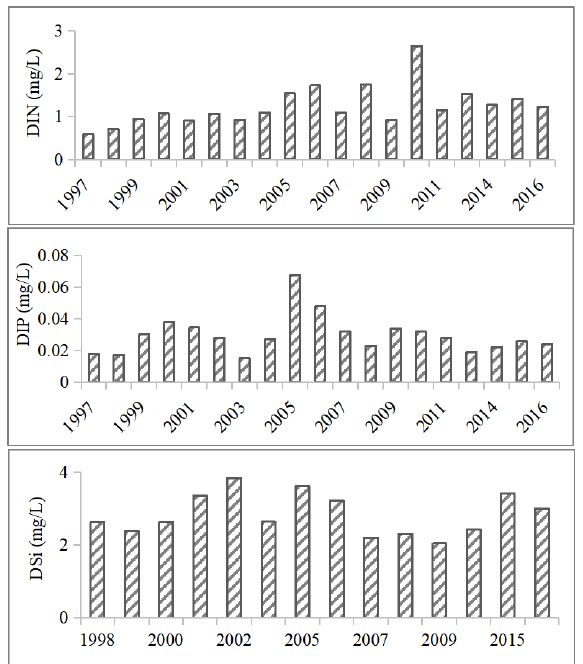
Figure 10. Time-varying trends of nutrients between 1997 and 2016 in the Pearl River estuary, historical data were provided as in [16,20,58–63] and our field